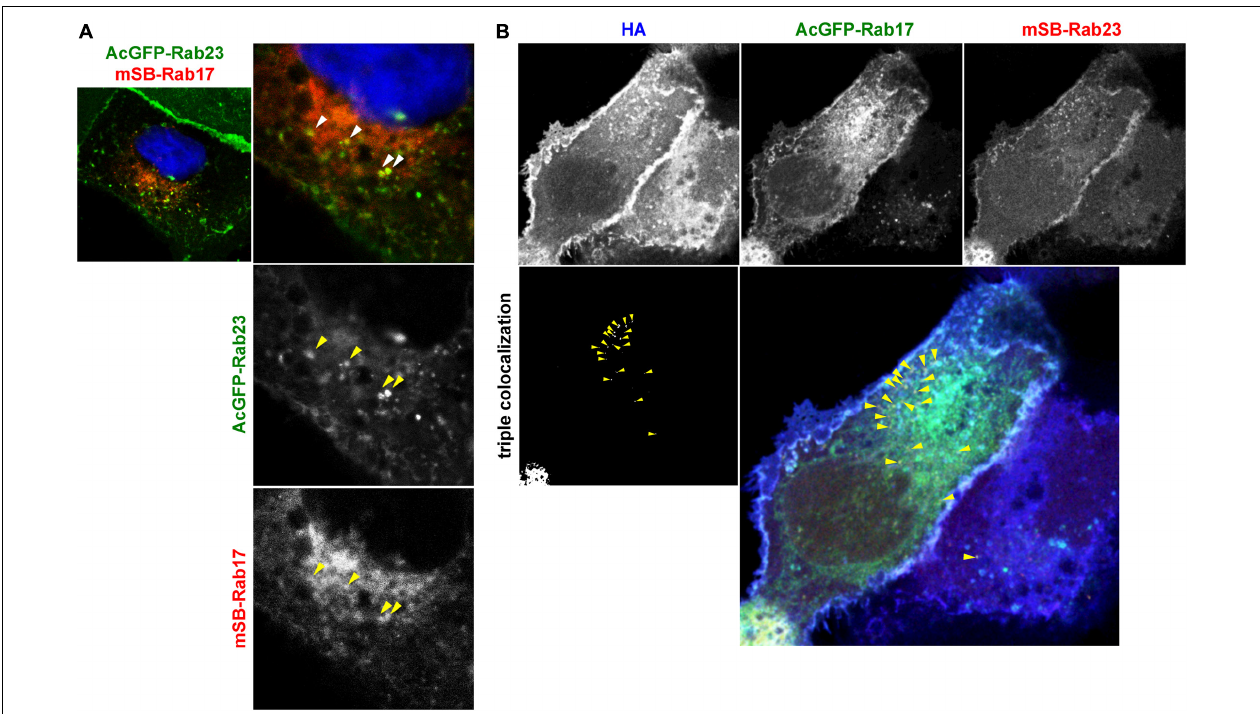
FIGURE 5 | Localization of HA to Rab17 and Rab23 double-positive vesicles. (A) Coexpression of AcGFP-Rab23 and mSB-Rab17. MDCK cells stably expressing AcGFP-Rab23 were transfected with an mSB-Rab17 expression plasmid. Cell nuclei (blue) were stained with DAPI. Arrowheads indicate colocalization of AcGFP-Rab23 and mSB-Rab17. (B) Triple expression of AcGFP-Rab17, mSB-Rab23, and HA. Parental MDCK cells were cotransfected with expression plasmids for AcGFP-Rab17 and mSB-Rab23. After 12 hpt, cells were transfected with an HA expression plasmid and were stained with anti-HA mAb (blue). Each channel image was shown in gray and triple merged images were shown in gray and color. Arrowheads indicate colocalization of HA with AcGFP-Rab17 and mSB-Rab23 double-positive